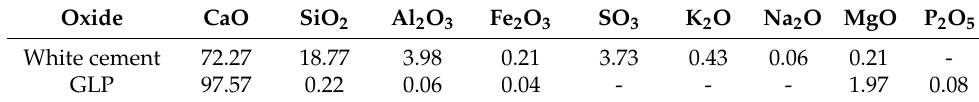
Table 2. Chemical composition of white Portland cement and GLP (%).